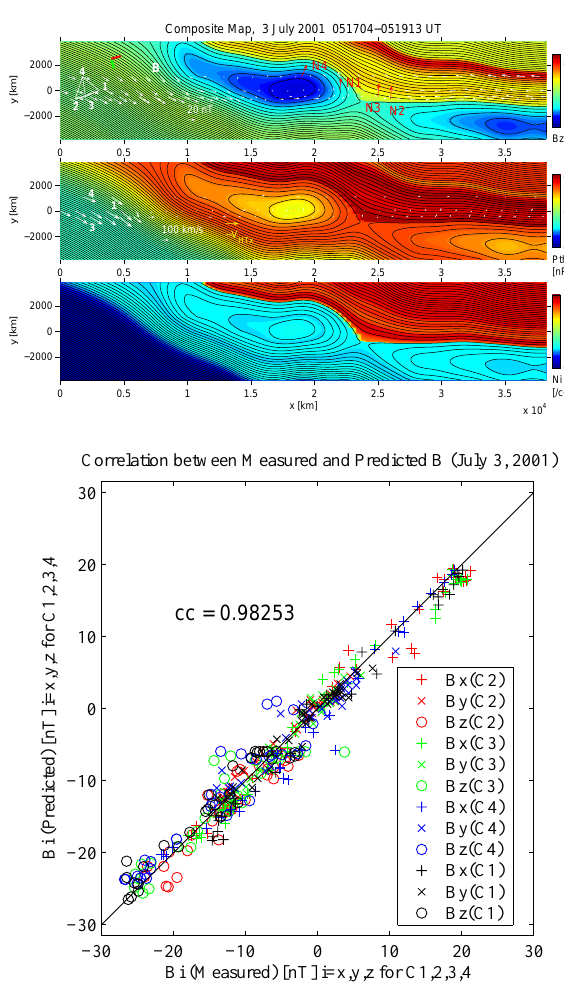
Fig. 7. Composite field maps and scatter plot of predicted versus measured field components for the interval 2 (the extended inter- val) of the 3 July 2001 event. In the top panel, white arrows show the measured field vectors and the colors represent the axial field component, while in the middle panel, the white arrows show the measured velocity vectors, seen in the HT frame, and the colors represent the plasma pressure. The bottom panel shows the ion den- sity color-coded. GSE coordinate axes of the map are x =(0.9532, 0.2702, − 0.1359), y =(0.2732, − 0.9620, 0.0029), with the same z axis as in Fig.